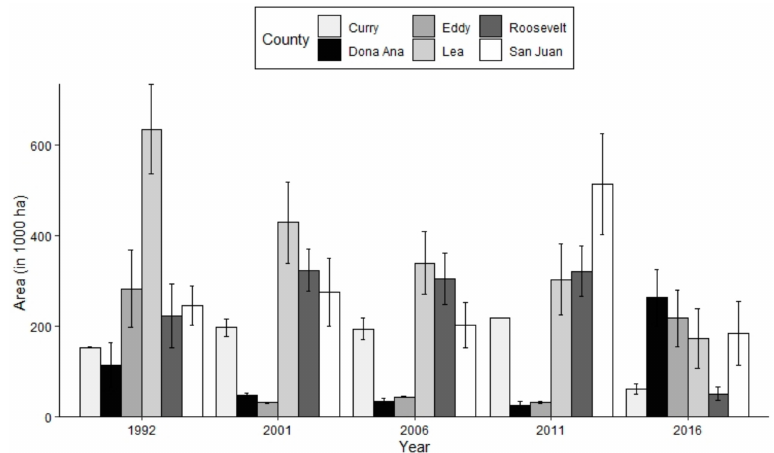
Figure 4. Area estimates of grassland in the study counties from 1992 to